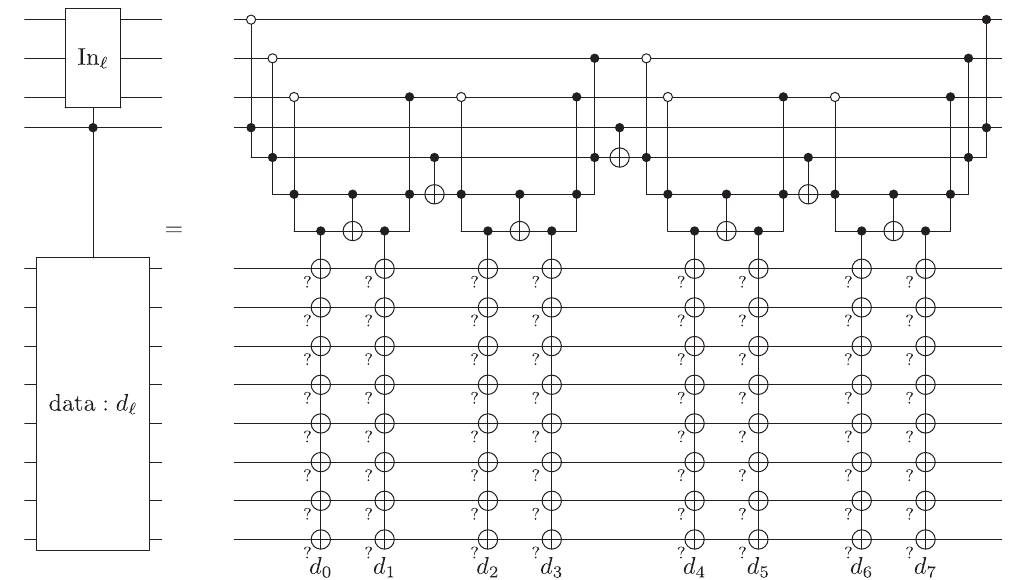
FIG. 10. Finite-sized example of the QROM database loading scheme used in our implementation of SUBPREPARE . If the index register ⃗ d is some precomputed data vector used when constructing the circuit. The top contains l , the output register ends up storing d l , where part of the circuit performs unary iteration, as described in Sec. III A. The bottom part of the circuit loads classical data associated with each possible index. The classical data are encoded into the presence or absence of CNOT s on the data lines. The “ ? ” marks in the diagram indicate that one should decide whether or not to have a CNOT gate on each line, depending on the value of the data to load. This circuit has a T count of 4 L − 4 , which is due entirely to the unary iteration. The T-gate cost of this circuit is independent of the number of bits used to store each element of the